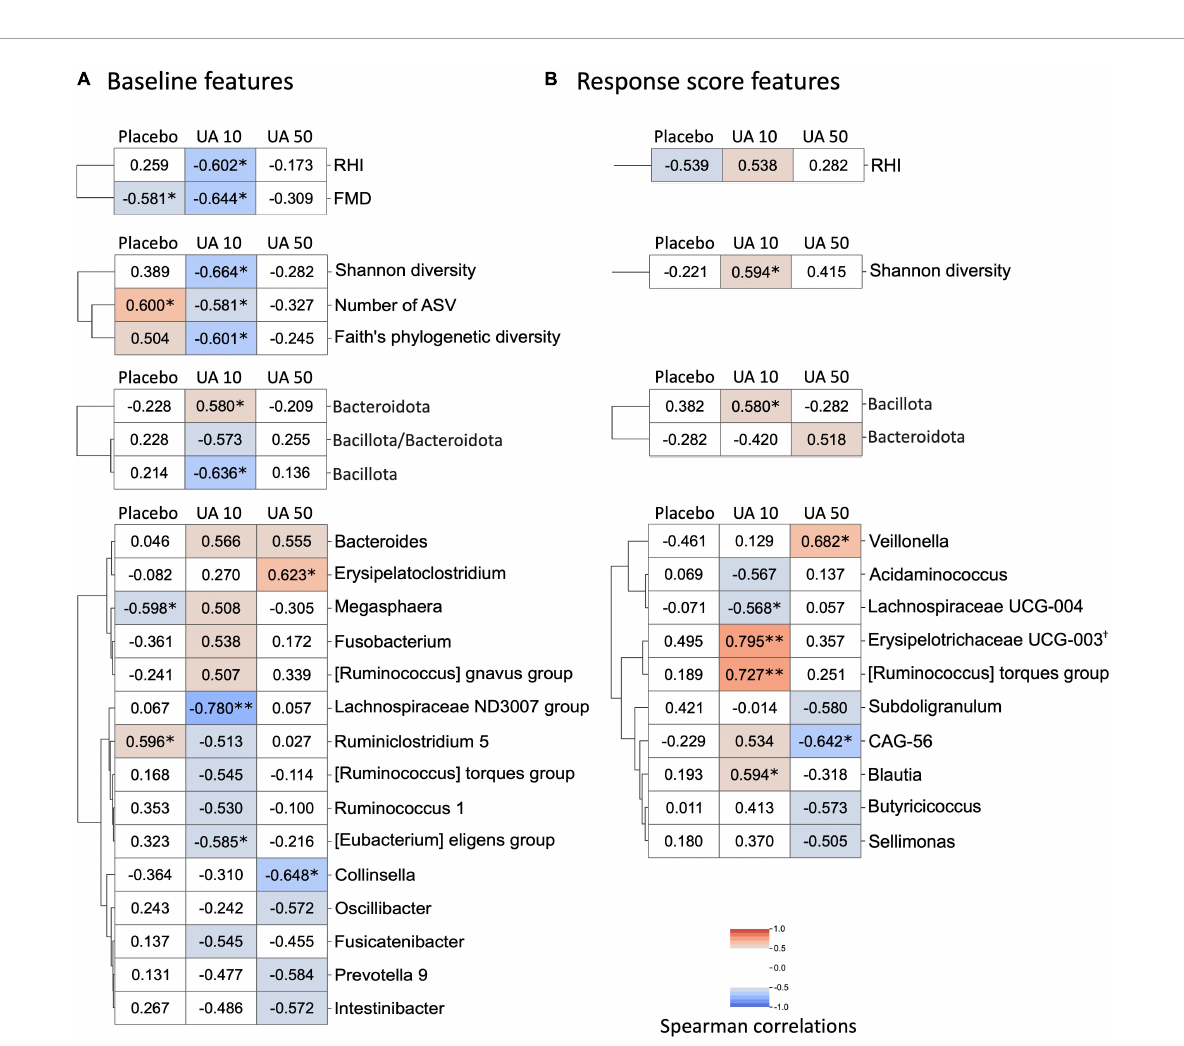
FIGURE4 Heatmap of correlation analysis of FMD response score. (A) Baseline features that correlated with FMD response score. Correlation analysis between FMD response scores and baseline gut microbes, organic acids, and VEF scores was performed. Correlations with statistical significance or with absolute Spearman’s correlation coefficient larger than 0.50 in either treatment group are shown in the heatmap ( ∗ p < 0.05; ∗∗ p < 0.01, Spearman’s correlation test). Row clustering using the Ward method was performed for each of the four data categories (VEF score, alpha-diversity, phylum, and genus). When FDR is corrected, none of the correlations are significant (FDR corrected q -value > 0.10). (B) Correlation analysis between FMD response score and gut microbes, organic acids, and VEF response scores. Correlations with statistical significance or with absolute Spearman’s correlation coefficient larger than 0.50 in either treatment group were shown in the heatmap ( ∗ p < 0.05; ∗∗ p < 0.01, Spearman’s correlation test; † FDR corrected q -value < 0.10). Row clustering using the Ward method was performed for each of the four data categories (VEF score, alpha-diversity, phylum, and genus). UA, urolithin A; UA 10, UA 10 mg/day; UA 50, UA 50 mg/day; VEF, vascular endothelial function; FMD, flow-mediated vasodilatation; RHI, reactive hyperemia index; FDR, false discoversy